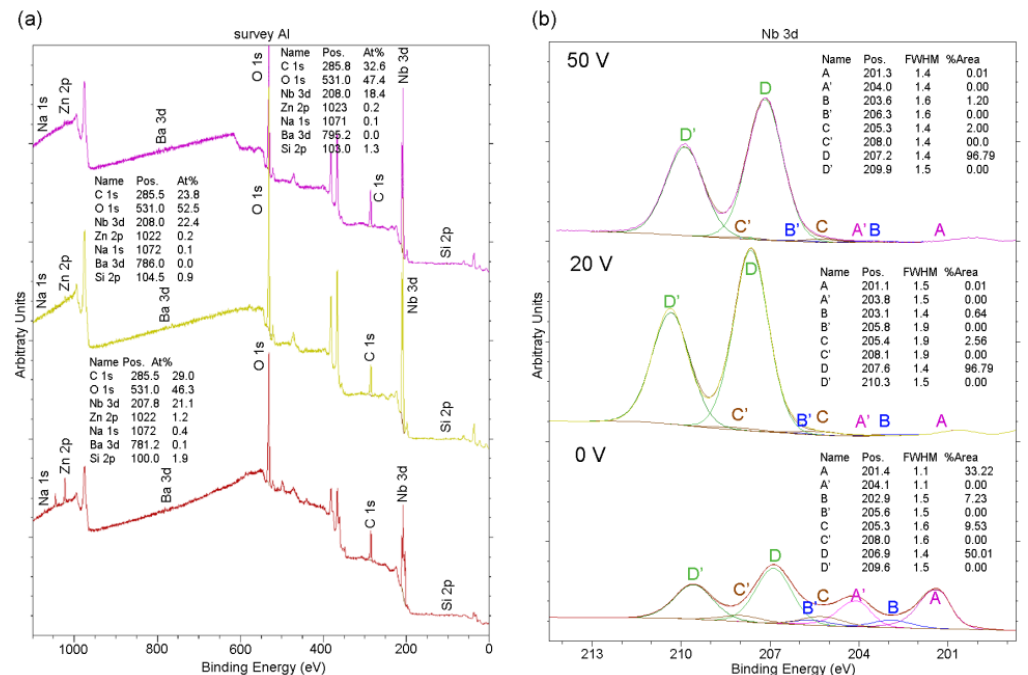
Figure 8. XPS ( a ) spectra for Nb anodized 0 V (bottom), 20 V and 50 V (top), ( b ) Nb 3d spectra.